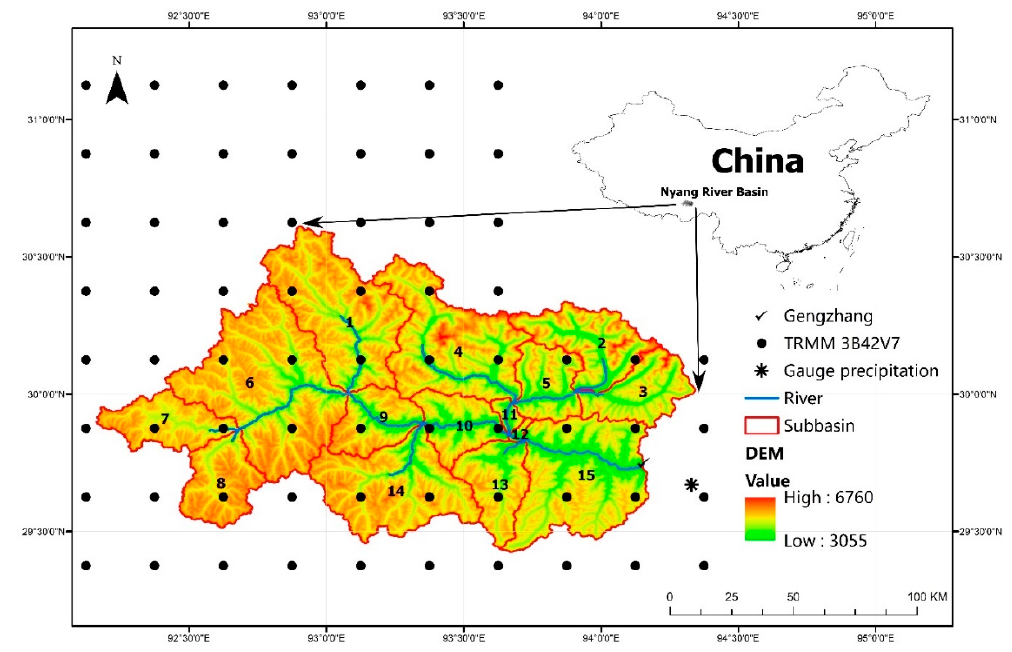
Figure 1. Location of the study area and spatial distribution of data used in the Soil and Water Assessment Tool (SWAT) model.